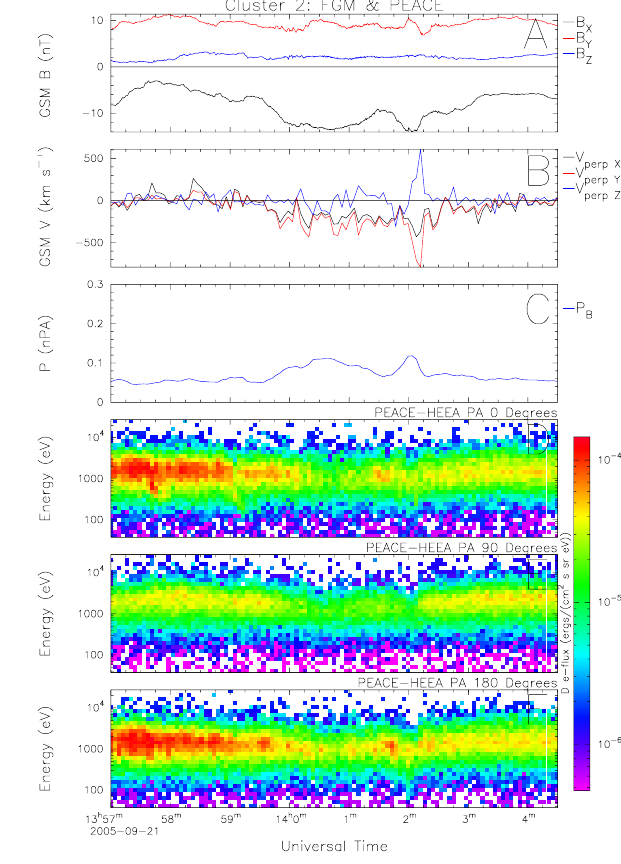
Fig. 6. C2 observations of the field dipolarisation and associated plasma features. Panel (A) shows GSM B X (black), B Y (red) and B Z (blue) from FGM, panel (B) GSM V ⊥ X (black), V ⊥ Y (red), V ⊥ Z (blue) and V // (green) for electrons from PEACE, panel (C) magnetic pressure (blue) and panels (D–F) energy time spectrograms from PEACE-HEEA for pitch angles of 0 ◦ , 90 ◦ and 180 ◦ ,